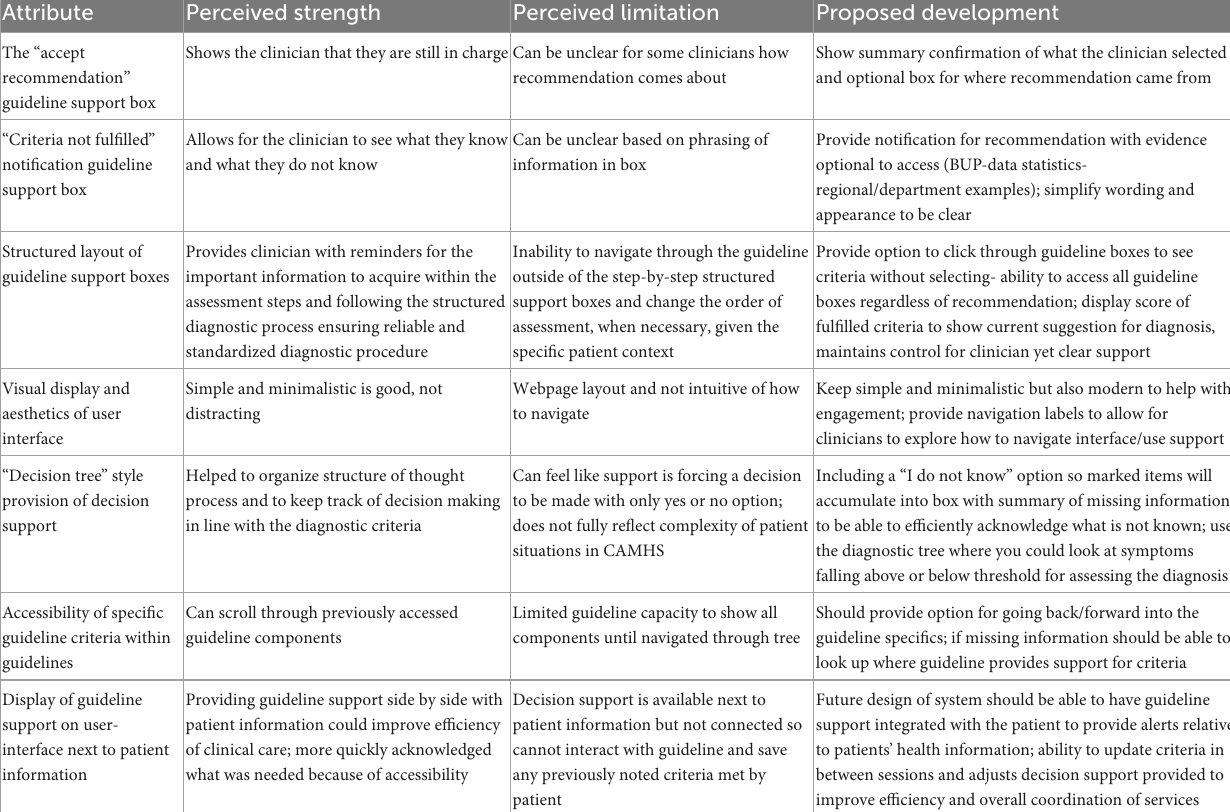
TABLE 1 Individualized Digital Decision Assist System (IDDEAS) prototype attributes: Perceived strengths and limitations.